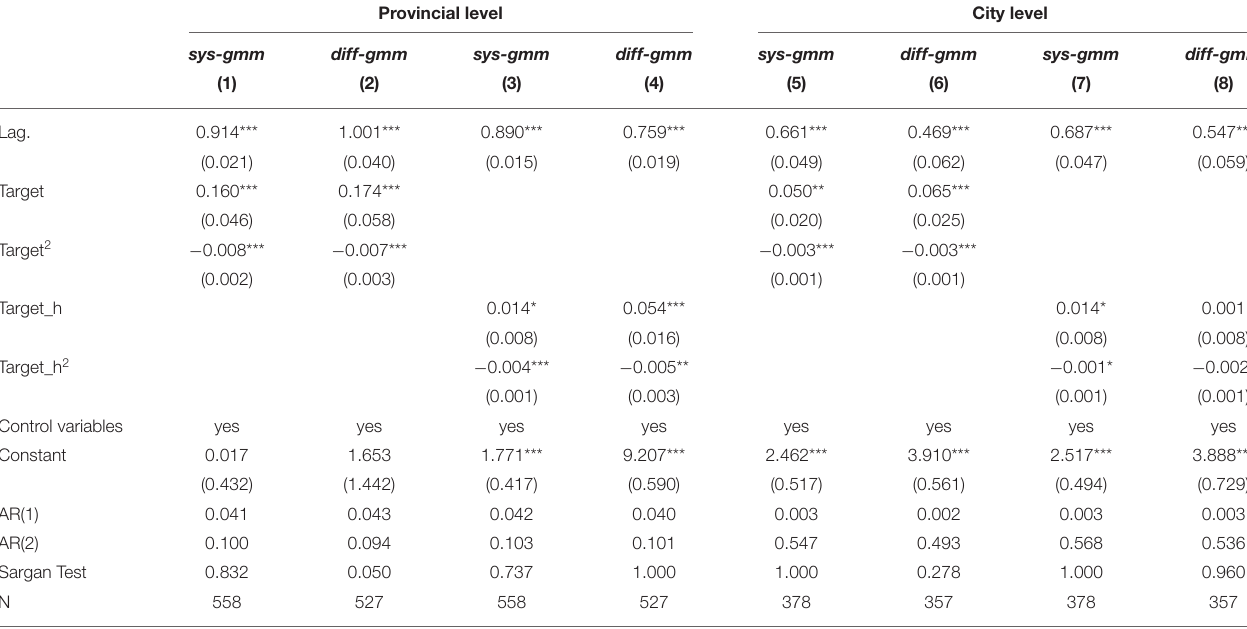
TABLE 4 | Regression results of generalised method of moments.